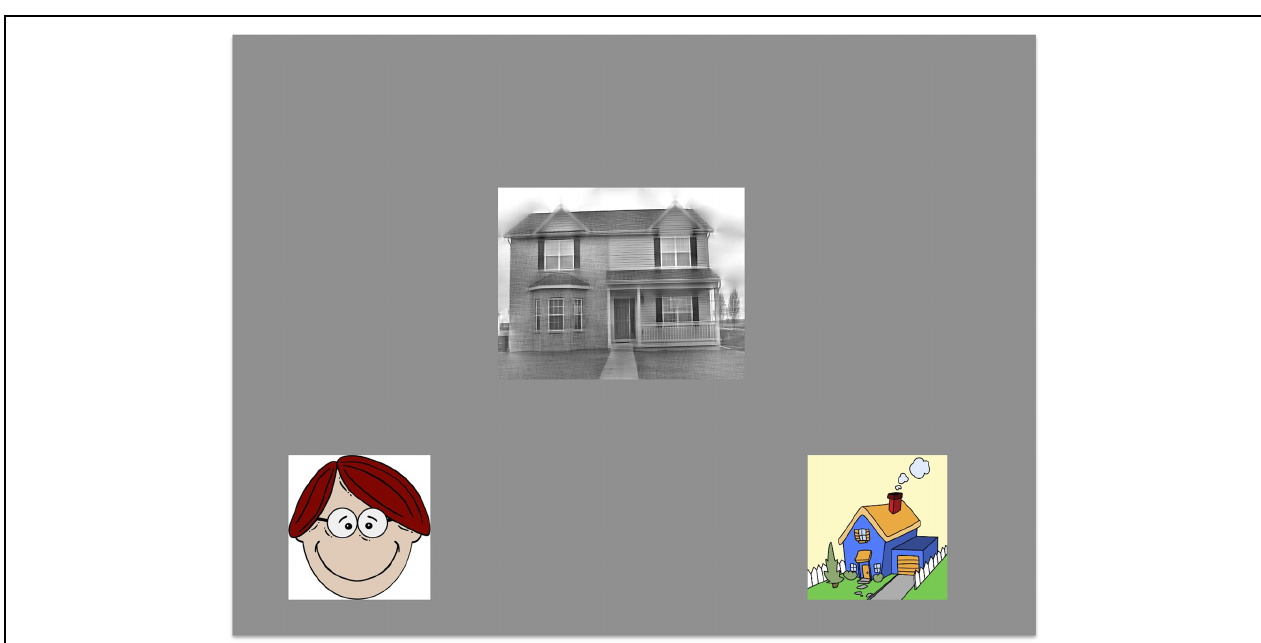
FIGURE 2 | An example trial from our task: participants were asked to categorize the central image by touching the cartoon image at the bottom of the screen that was of the same object